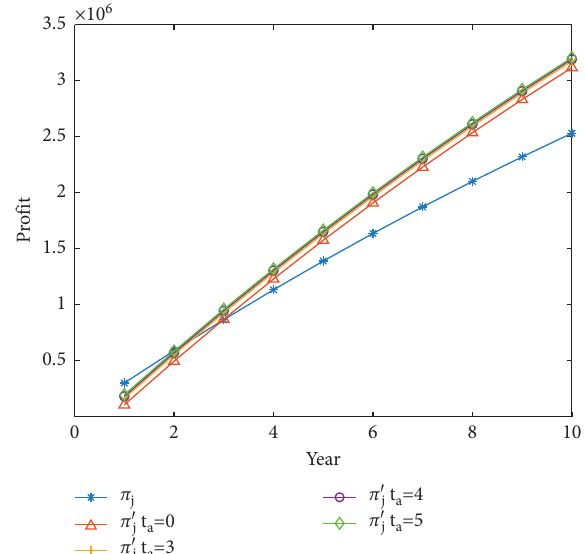
Figure 9: Profits of retailers with q t � 0 , 3 , 4 , a